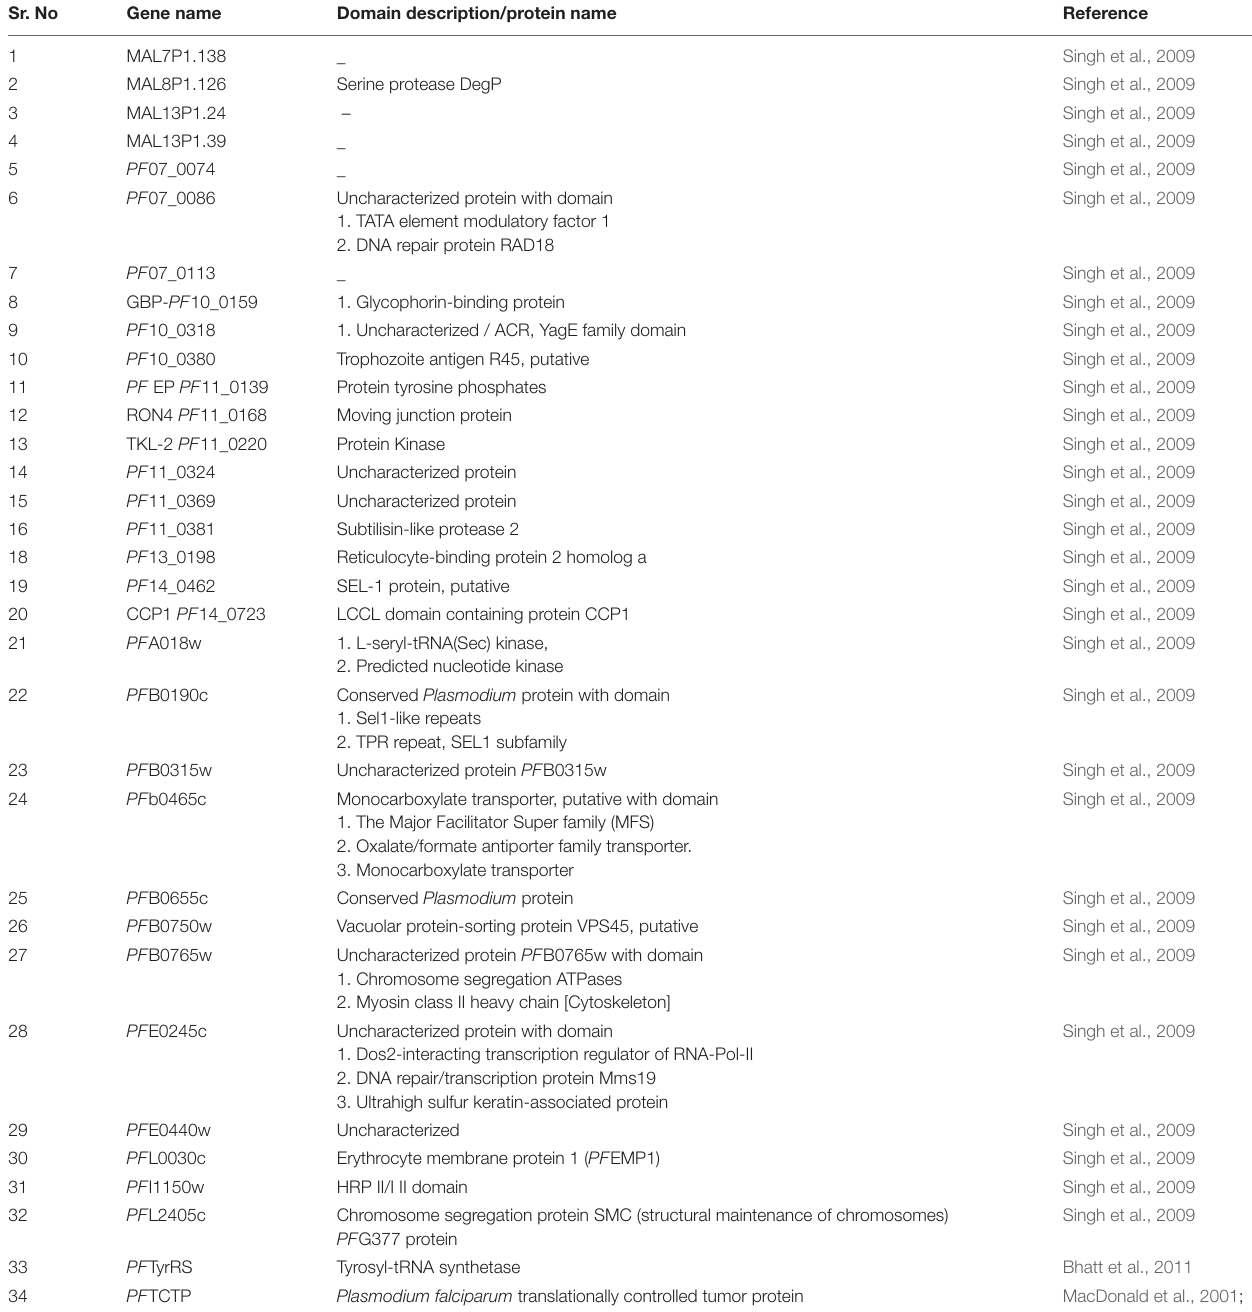
TABLE 1 | Some secretory protein exported out from the iRBC. Sr.